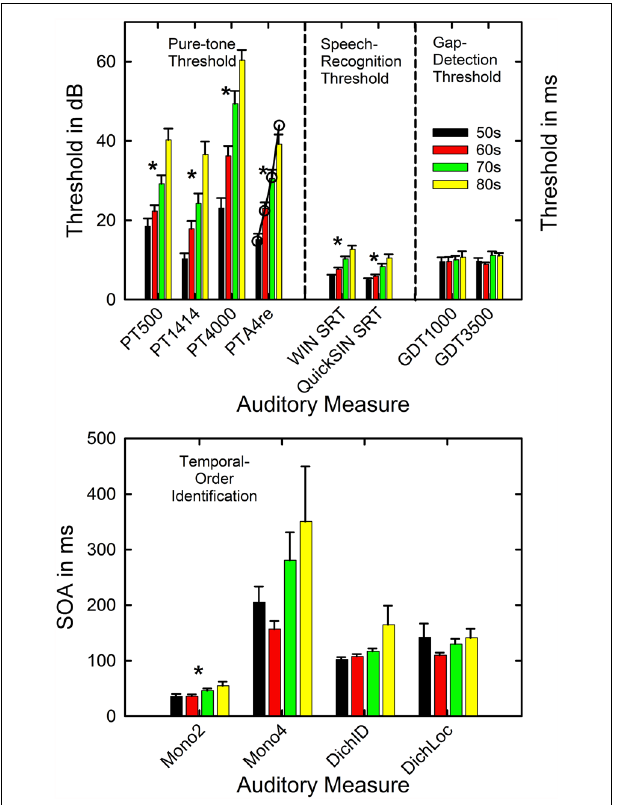
FIGURE 3 | Means and standard errors are shown by age decade for each of the four types of auditory measures completed in this study. The asterisks mark those measures for which a significant effect of age decade was observed. The open circles in the top panel for PTA4re show comparison data from a population study of older adults in the US from Cruickshanks et al. (1998). PT = pure-tone threshold in dB SPL and 500, 1,414, and 4,000 represent the three test frequencies. PTA4re = pure-tone average for 500, 1,000, 2,000, and 4,000 Hz in the right ear in dB HL. SRT = speech-recognition threshold in dB; GDT = gap-detection threshold in ms. The x-axis labels in the lower panel show the four conditions for the temporal-order identification measures with the stimulus onset asynchrony (SOA) plotted in ms. Mono2 = monaural two-item. Mono4 = monaural 4-item. DichID = dichotic with vowel identification. DichLOC = dichotic with ear or location